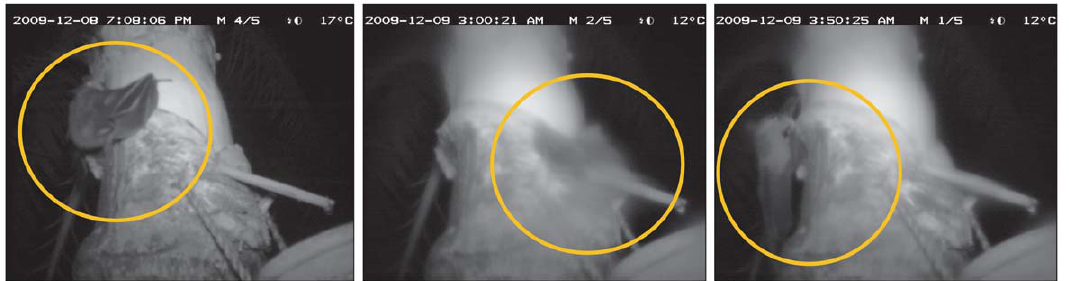
Figure 3. Identifying bats visiting date palm tree on a foggy night: a. 7:08 PM, no fog, bats are easily identifiable; b. 3:00 AM, fog blurs visibility but bats are somewhat identifiable; c. 3:50 AM, fog starts to clear and bats appear clearly in the photos. Each image shows bats in a circle, observation date, time, and ambient temperature when it was taken.